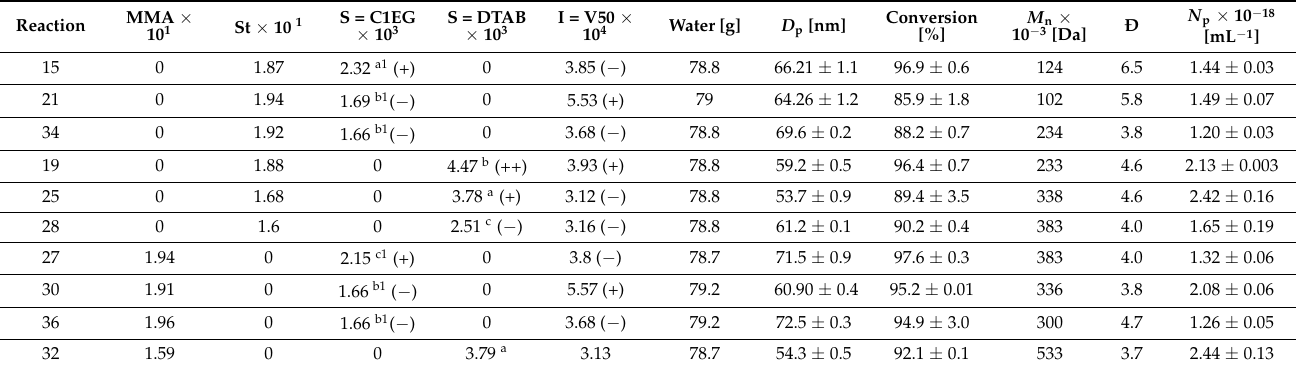
Table 1. Experimental design and main responses of the EPs carried out at 70 ◦ C. All quantities in the recipe are in moles (columns 2–7) except for water. S = surfactant; I = initiator. The groups of reactions (in different colors) correspond to fractions of a factorial experimental design for a fixed monomer and type of surfactant.